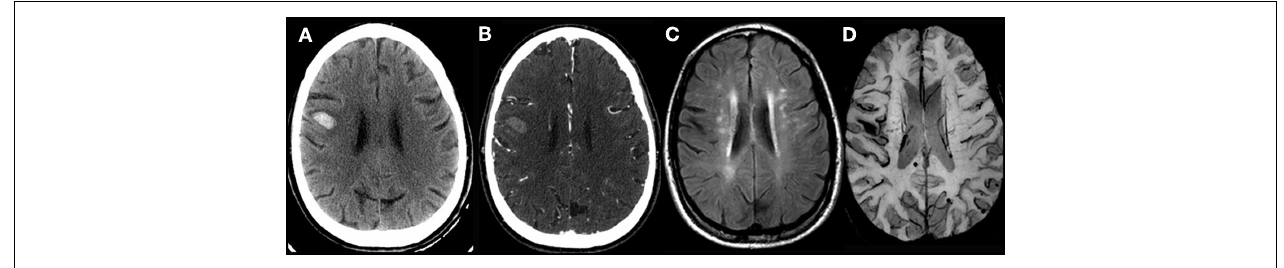
white matter changes are seen on fluid attenuated inversion recovery (FLAIR) MRI. (D) Multiple susceptibility foci are present on echoplanar-gradient echo MRI sequence fulfilling the Boston criteria for probable CAA.